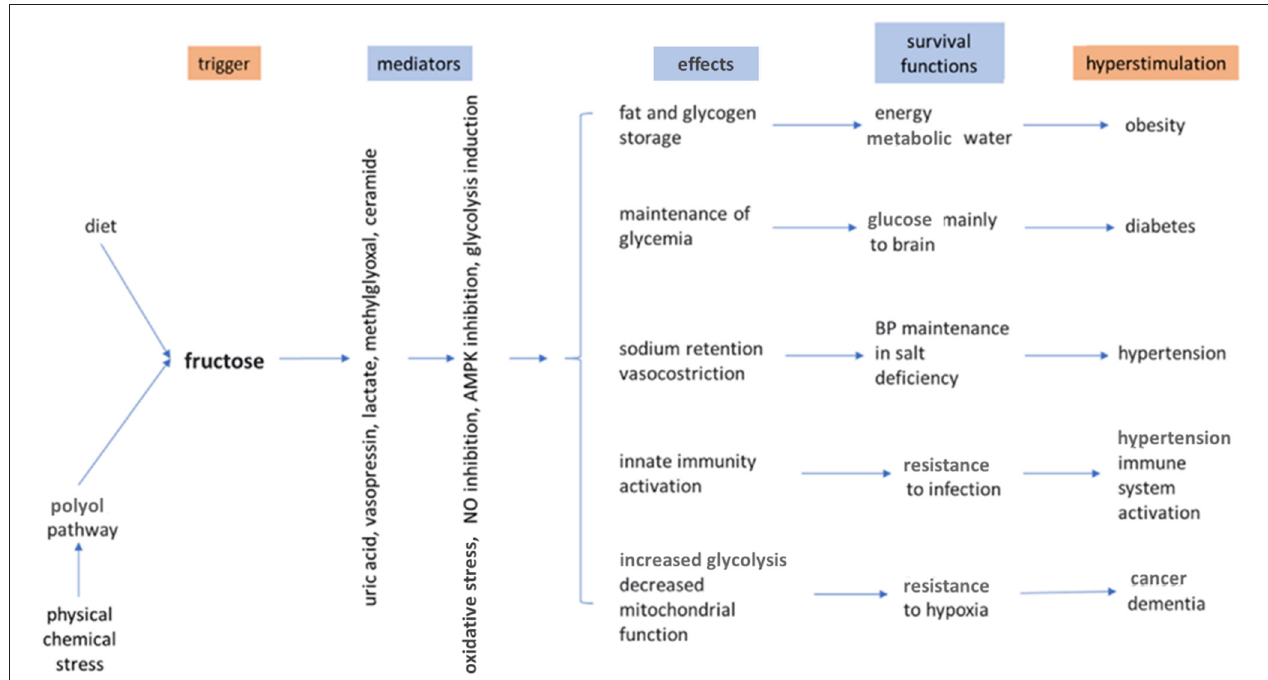
FIGURE 2 | Effects of endogenous and dietary fructose. AMPK, Adenosine monophosphate kinase; NO, nitric oxide. Modified from Johnson et al. (13).